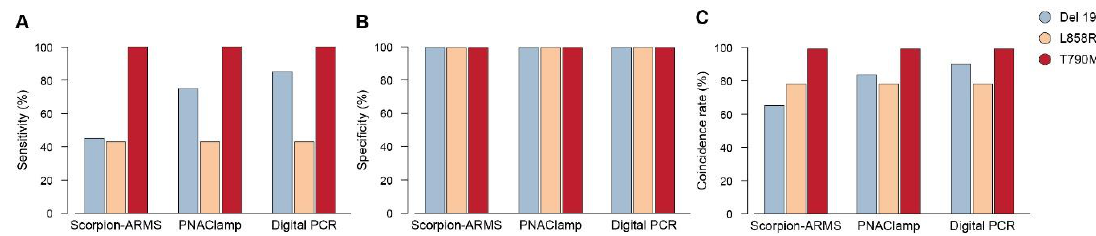
Figure 1. Levels of sensibility, specificity and coincidence rate of the three methods in detecting epidermal growth factor receptor ( EGFR ) mutations in plasma samples. EGFR mutations as detected in liquid biopsy at baseline through cell-free tumor DNA (cftDNA) analysis by the Scorpion-ARMS EGFR Plasma RGQ PCR Kit-QIAGEN, PNAClamp EGFR -PANAGENE, and the QuantStudio 3D Digital PCR System-Thermo Fisher Scientific. ( A ) Sensitivity, ( B ) specificity, and ( C ) coincidence rate of each of these three assays, were calculated on the basis of tissue analysis.